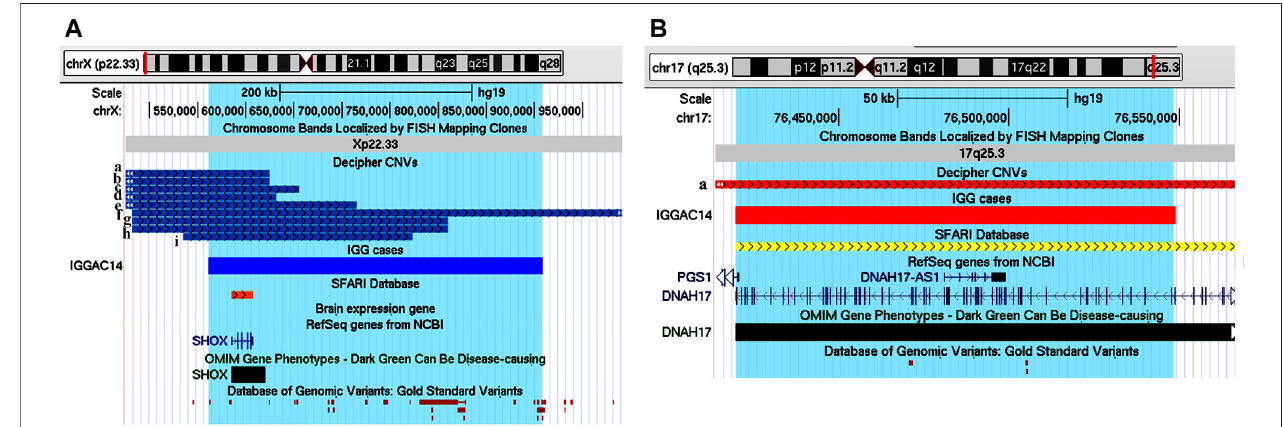
FIGURE 2 | Additive effects between SHOX and DNAH17 in patient IGGAC14. (A) Screenshot of chromosome X region overlapping the duplication of patient IGGAC14 (blue bar, chrX:561,527-908,212). Duplications in Decipher database (a: patient 259967; b: patient 367079; c: patient 380394; d: patient 284815; e: patient 289670; f: patient 322776; g: patient 367150; h: patient 279033; i: patient 353723). (B) Screenshot of chromosome 17 region encompassing the deletion of patient IGGAC14 (red bar, chr17:76,419,867-76,548,866). Deletions in Decipher database (a: patient